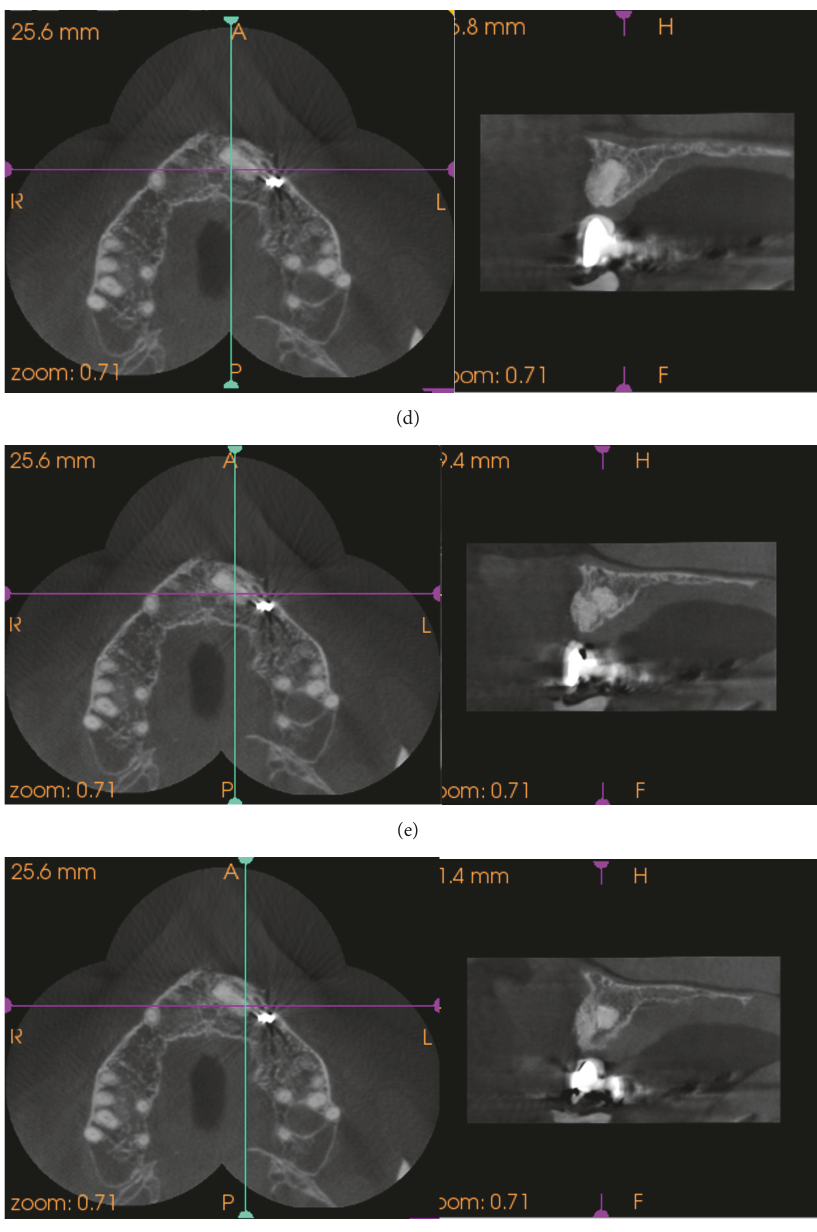
Figure16:(a)CBCT(CarestreamCS9000)imagerytakenat8monthspostoperativelydisplayingtheextentofthenewlyintegratingxenograft. (b)–(f) The sagittal views of these films show the well-defined morphology of the aberrant neurovascular